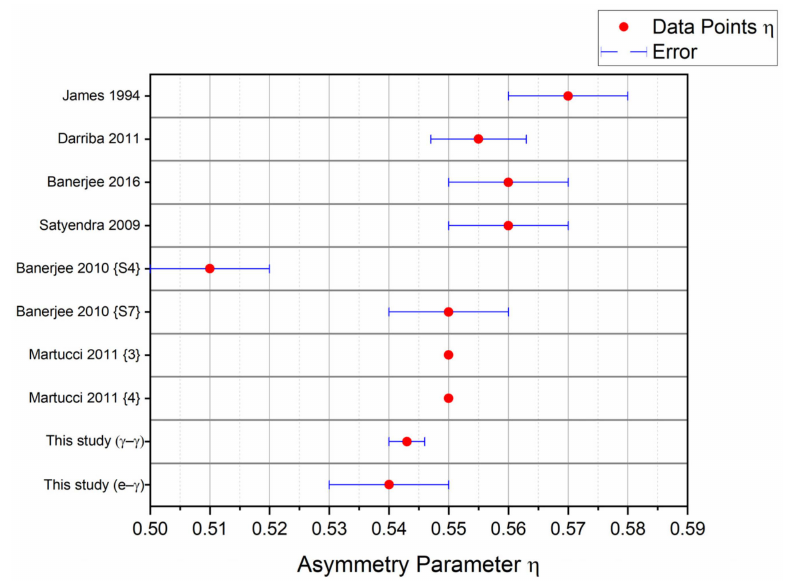
Figure 11. The values of η obtained from our γ − γ and e − γ experiments are visually compared with accepted literature values from Table